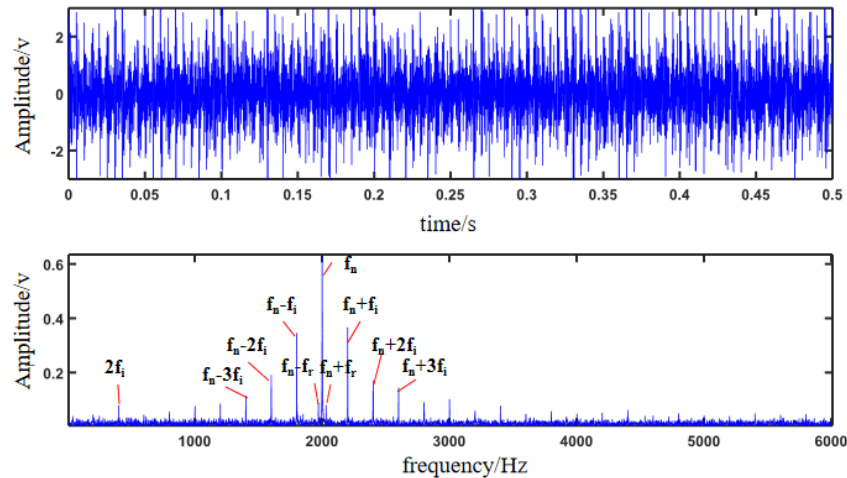
Figure 6. Corrupted simulation signal with noise.